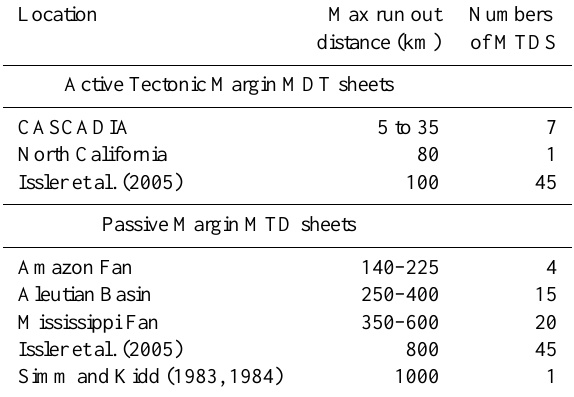
Table 1. Comparison of mass transport deposit sheets on unconfined basin floors along active and passive margins. Apparently because of seismic strengthening in active margins, maximum runout dis- tances from the basin slope for mass transport deposits (MTDs) are up to 10 times more on passive margins. (Table is modified from Nelson et al.,